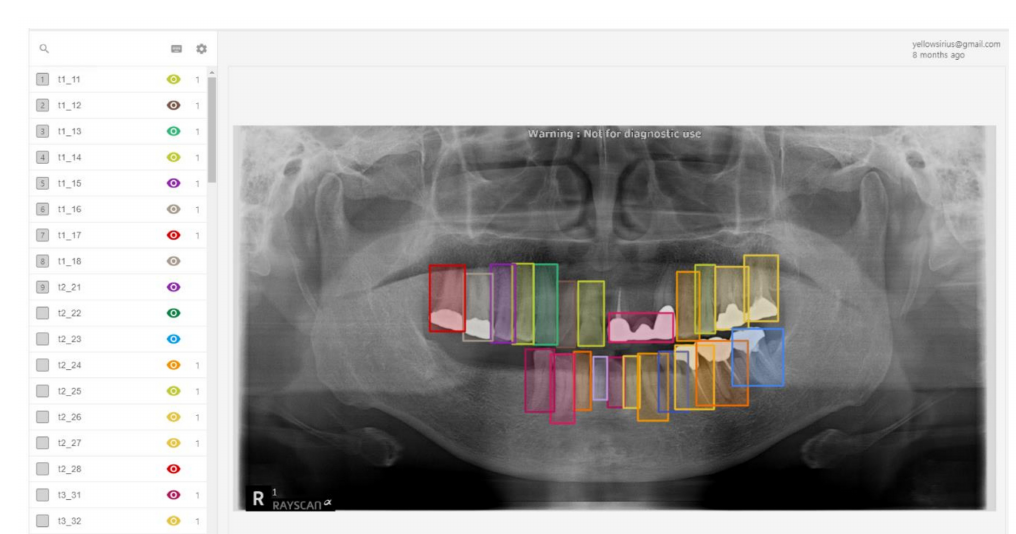
Figure 4. Labeling tool used to generate training and test sets.